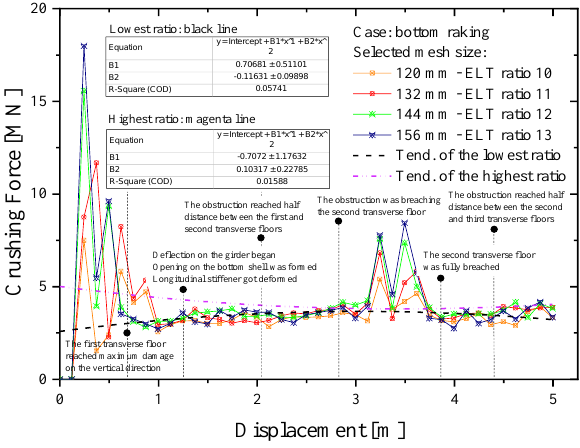
Figure 9. Progressive structural failure on the double bottom during accidental grounding process.